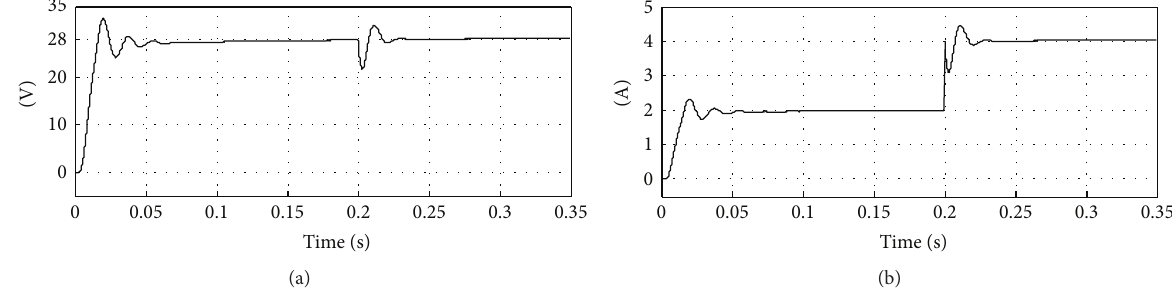
Figure 7: Simulation of buck-converter with constant voltage loads.